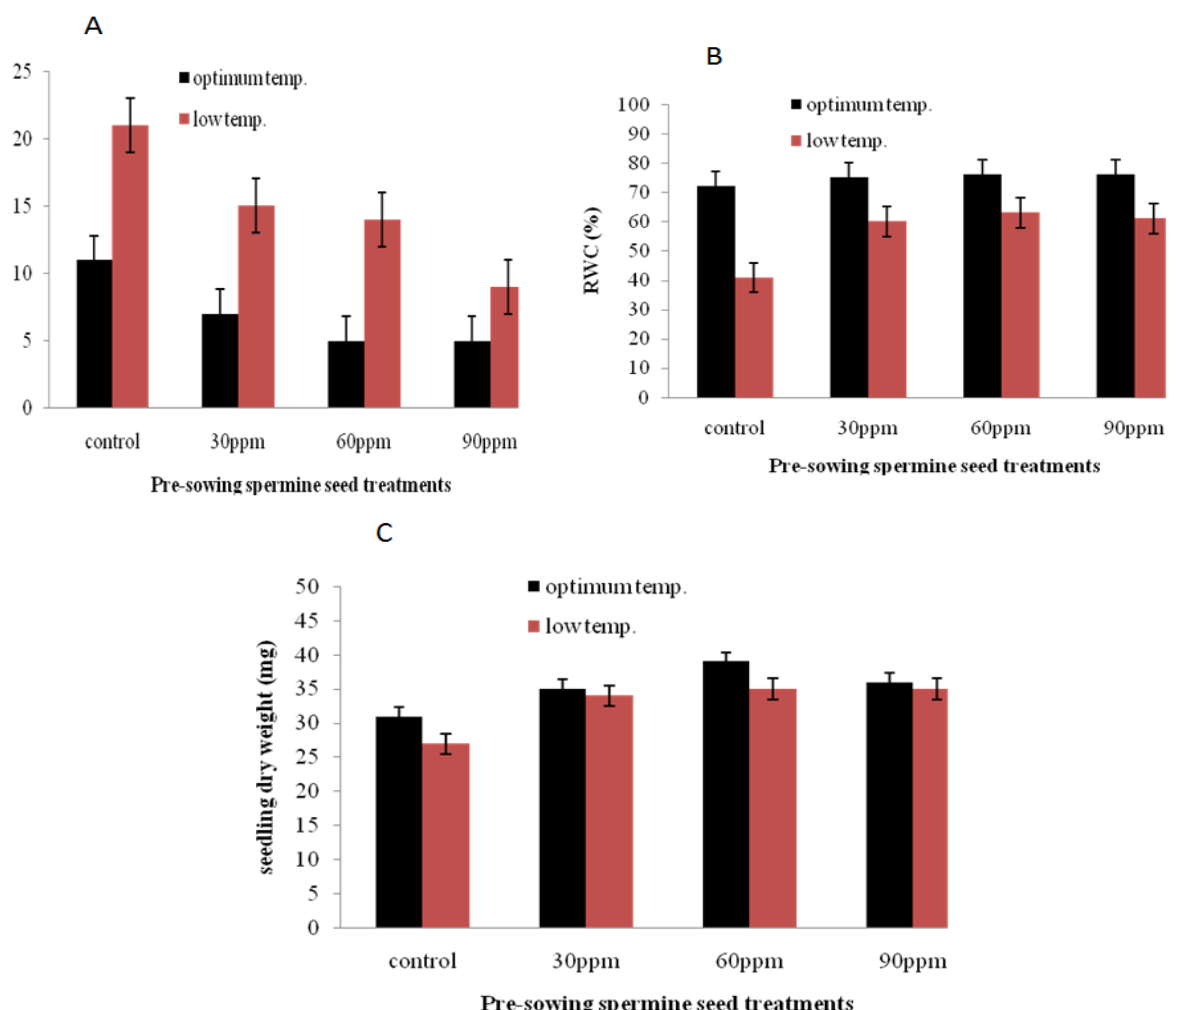
Fig. 3. Effect of spermine application on electrolyte leakage (A), relative water content (RWC) (B) and seedling dry weight (C) of maize seedlings under optimum and low temperature conditions. Data are the mean value of three replications ± SE which repre- sented by the vertical bar in each